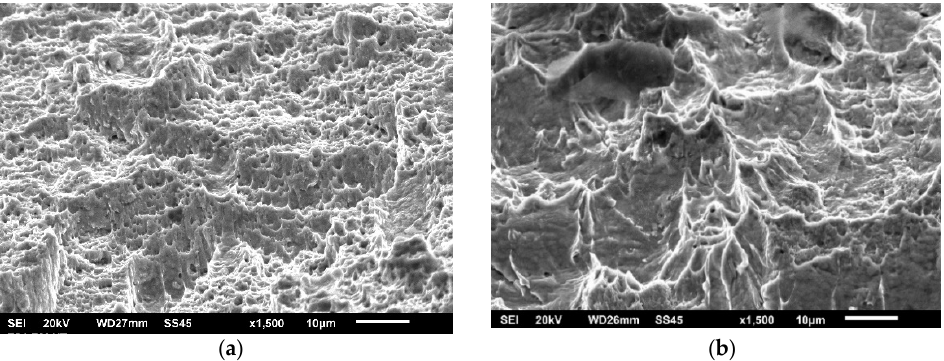
Figure 14. SA ‐ 387 Gr. 91 BM fractography. ( a ) SENB specimen 20 ° C, ( b ) CT specimen 575 ° C, 1500×. Figure 14. SA-387 Gr. 91 BM fractography. ( a ) SENB specimen 20 ◦ C, ( b ) CT specimen 575 ◦ C, 1500 × .